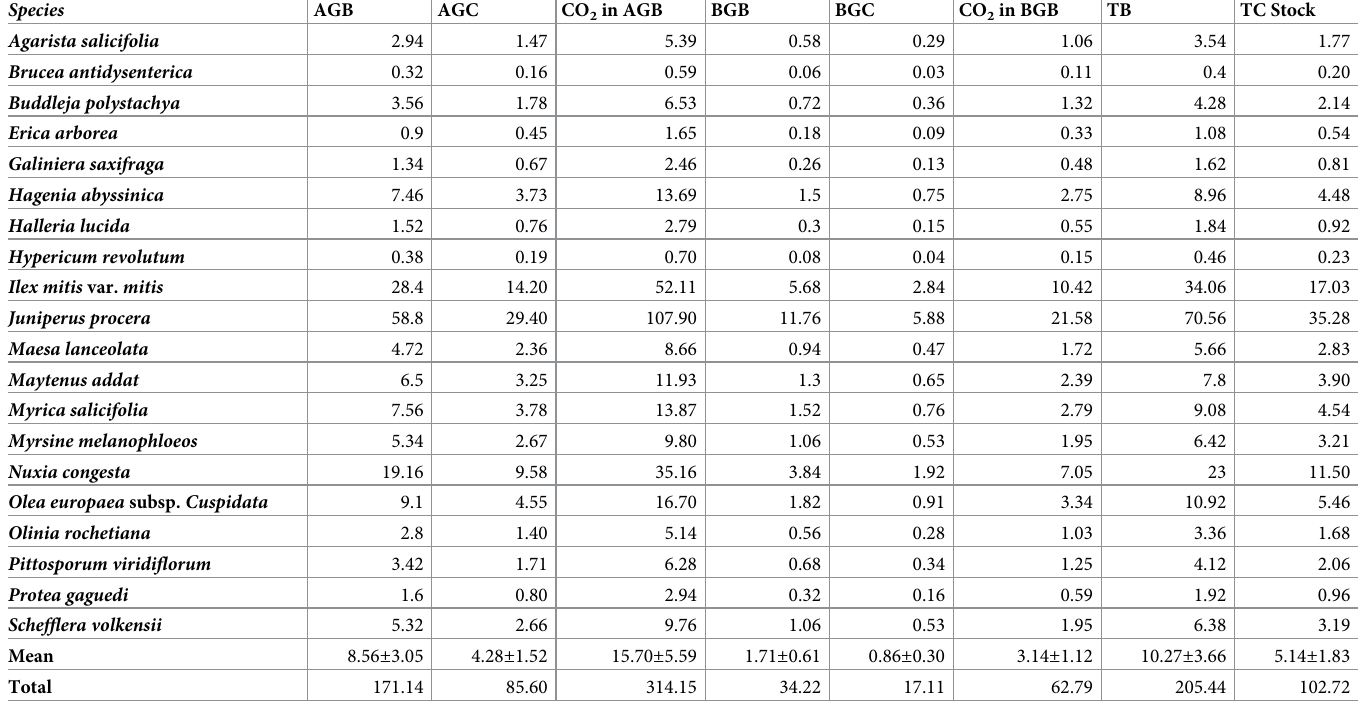
Table 2. Carbon stock pools (Mg ha − 1 ) across the tree species in Kibate Forest. Species